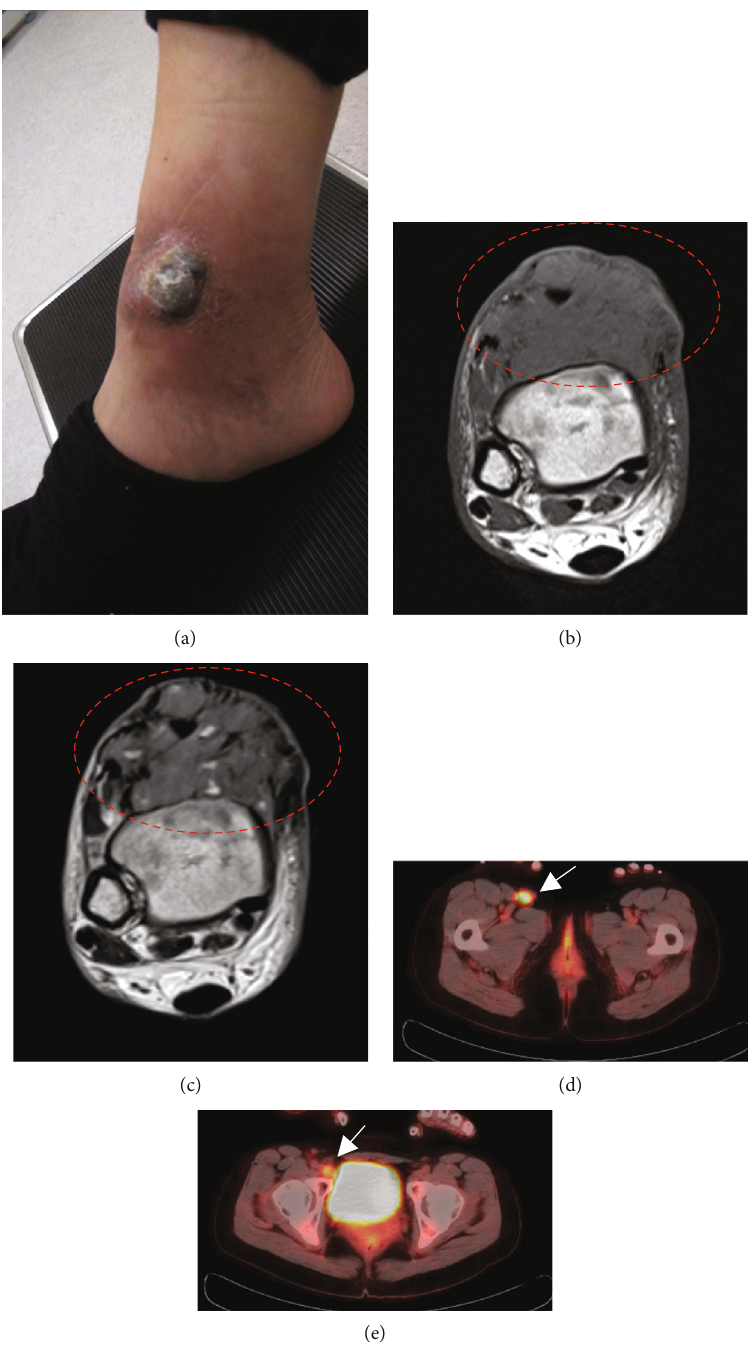
Figure 1: Local recurrence and lymph node metastasis at the initial visit. (a) Visual appearance of the ankle region during the patient ’ s fi rst visit to our hospital. (b) Axial image of the ankle region acquired using T1-weighted MRI. (c) Axial image of the ankle region acquired using T2-weighted MRI. (d) Axial image focused on the inguinal iliac lymph node acquired using positron emission tomography (PET). (e) Axial image focused on the external iliac lymph node acquired using